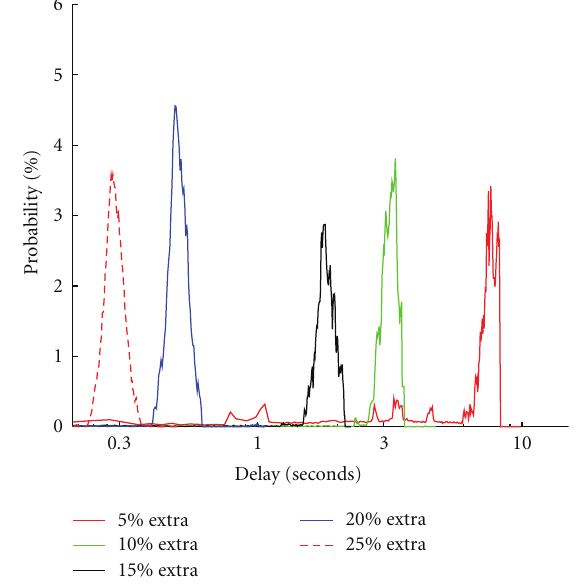
Figure 10: Plot of end-to-end delay versus excess bandwidth for multicast tra ffi